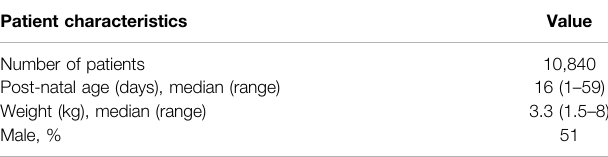
TABLE 1 | Demographic characteristics of the pediatric patients enrolled in the AFRINEST and SATT trials (Zaidi et al., 2013b; African Neonatal Sepsis Trial et al., 2015; Baqui et al., 2015), which were used in subsequent simulation